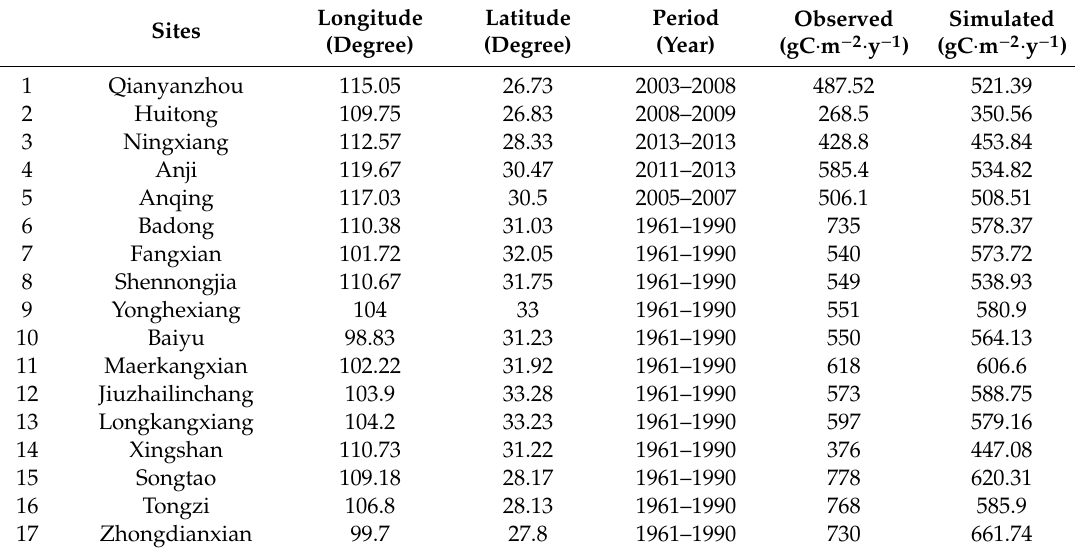
Table 1. Comparison of forest NPP simulated by LPJ model with that from the observation sites in Yangtze River basin.